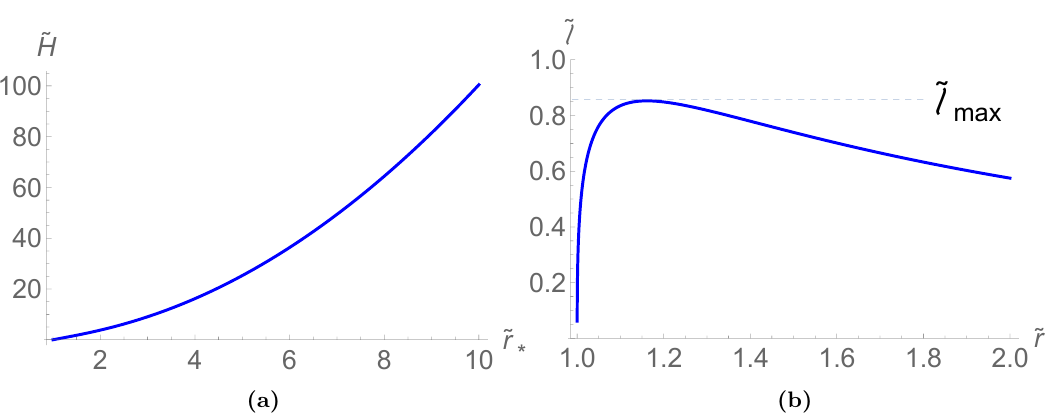
Figure 6. ~ H (~ r (cid:3) ) and ~ l (~ r (cid:3) ) for a connected surface. Here the dimensionless quantities are de(cid:12)ned in (4.14) and